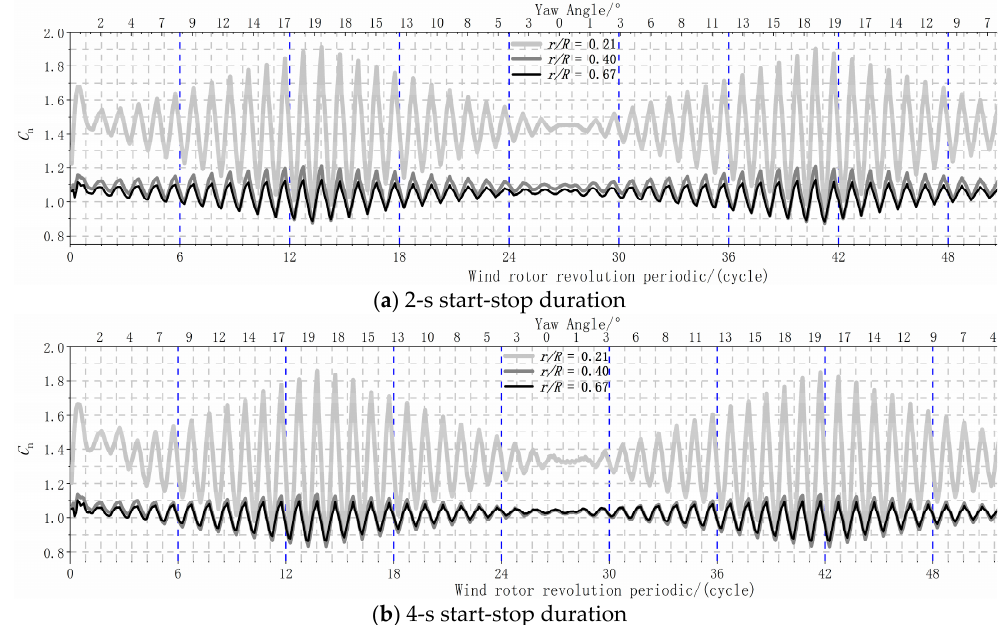
Figure 27. Comparison of C n under different start-stop durations for three different spanwise sections under dynamic yawing.